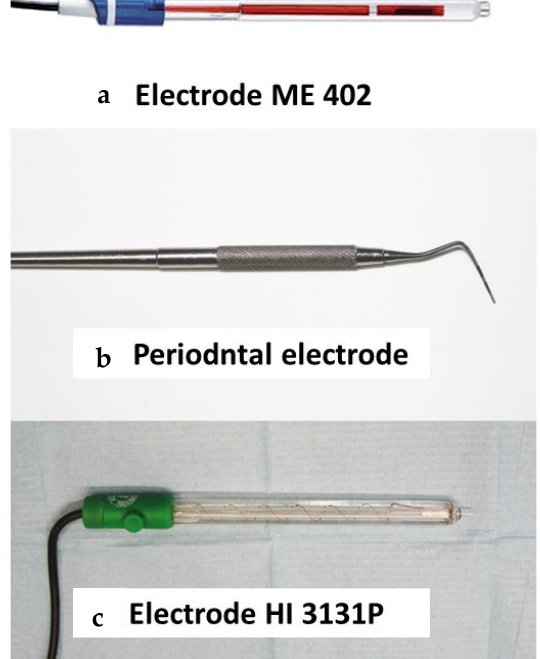
Figure 4. Different electrodes used in these measurements. ( a ) Reference electrode suitable for general laboratory use. ( b ) Stainless steel periodontal probe. ( c ) Combined electrode with platinum tip and integrated reference electrode.